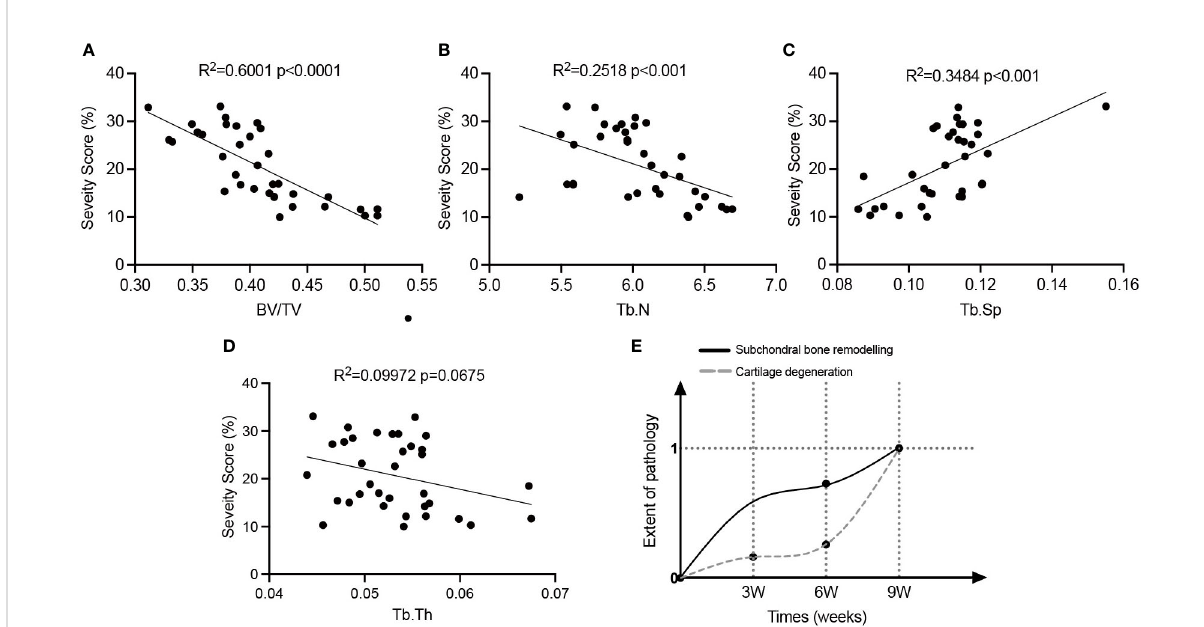
FIGURE 4 The relationship between subchondral bone alterations and cartilage degeneration in OVX-OA rats. (A – D) : Linear regression analysis of the severity of articular cartilage and microarchitectural changes of subchondral bone (n = 35). (E) The developed model illustrating pathologies of subchondral bone and cartilage in OVX-OA. BV/TV, bone volume/tissue volume. Tb. N, trabecular number. Tb. Sp, trabecular separation. Tb. Th, trabecular